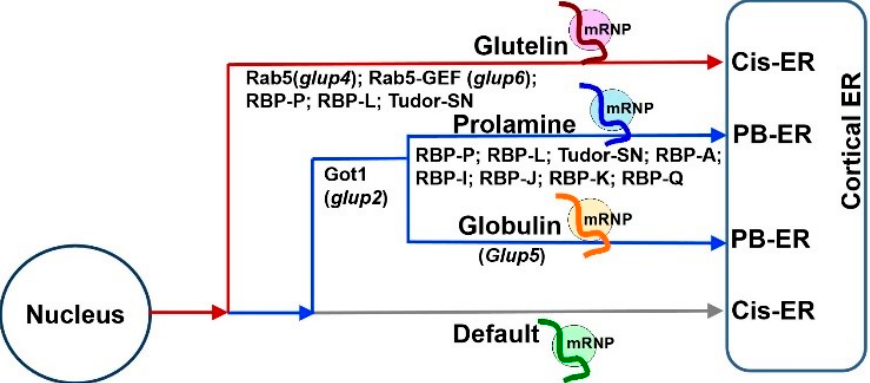
Figure 3. The hierarchal relationship among the three mRNA transport pathways in developing rice endosperm (adapted from [35]). The glutelin mRNA localization pathway to the cis-ER (red) is dominant over the pathway targeting prolamine/ α -globulin mRNAs to the PB-ER (blue), which, in turn, is dominant over the default pathway (gray). Studies from mutant rice lines expressing defective Got1 ( glup2 ), Rab5 ( glup4 ) and Rab5-GEF ( glup6 ), indicate that membrane trafficking mediates the mRNA transport to the PB-ER or cis-ER. Another rice mutant, glup5 , possessing an undefined genetic defect, misdirects α -globulin mRNAs to the cis-ER without affecting the localization of prolamine mRNAs to the PB-ER. The key RBPs responsible for glutelin and prolamine mRNA localization, are marked un- der each pathway. The three RNA-transport pathways may share some common RBPs or factors for mRNA targeting to the cortical ER membrane, while additional specific factors are required for se- lective transport during each pathway.